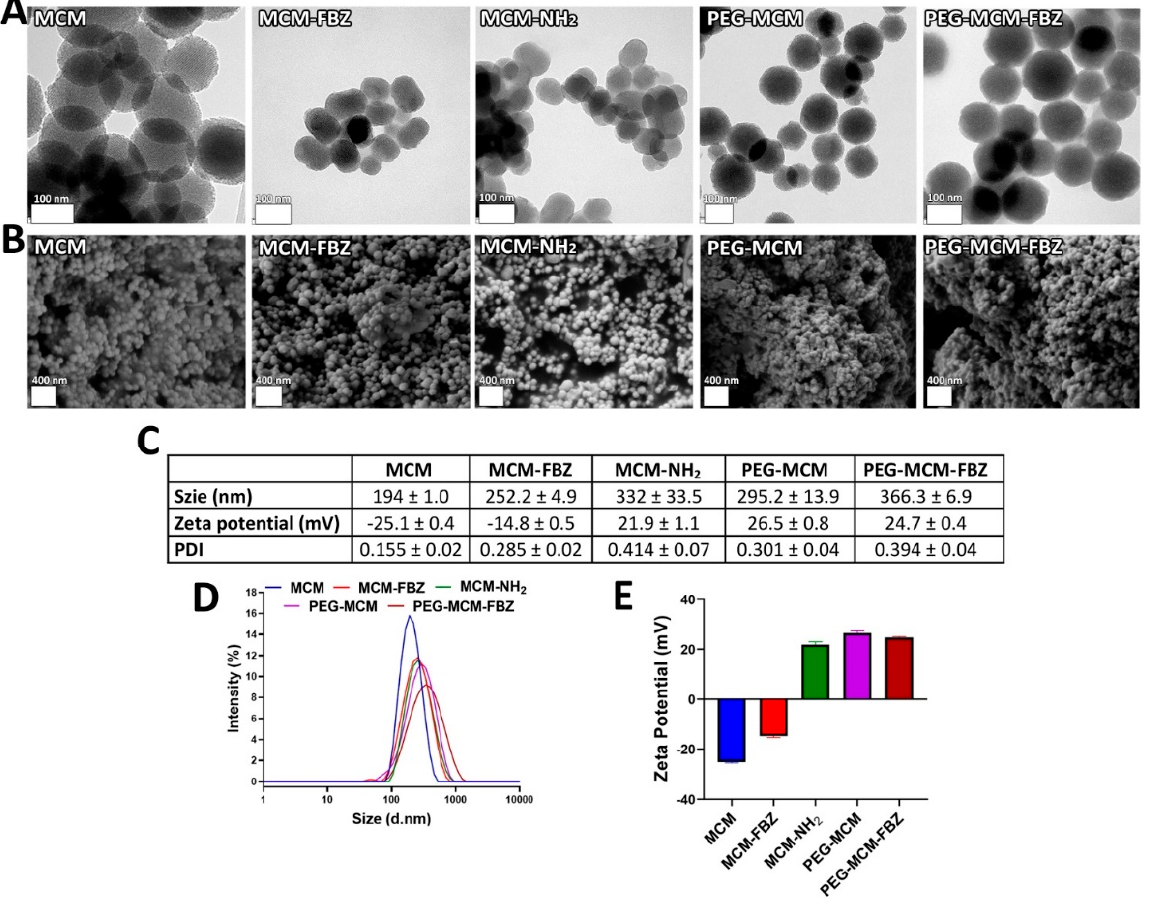
Figure 1. Characterization of MCM, MCM − FBZ, MCM − NH 2 , PEG − MCM, and PEG − MCM − FBZ NPs, in terms of morphol- ogy, using ( A ) TEM and ( B ) SEM methods. Results of ( C , D ) NP size distribution, ( C , E ) zeta potential, and ( C ) polydispersity index (PDI) demonstrate that homogenous and monodisperse NPs were synthesized.